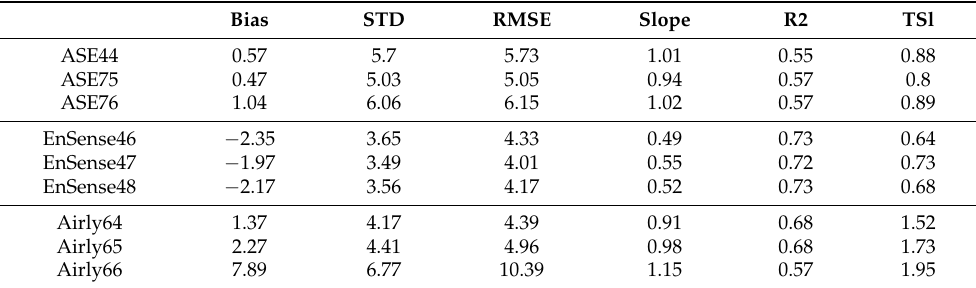
Table 3. Summary statistics of applying the sensor-specific multilinear regression models to the testing period at Kirkeveien. Reference instrument is Fidas and component is PM 2.5 .